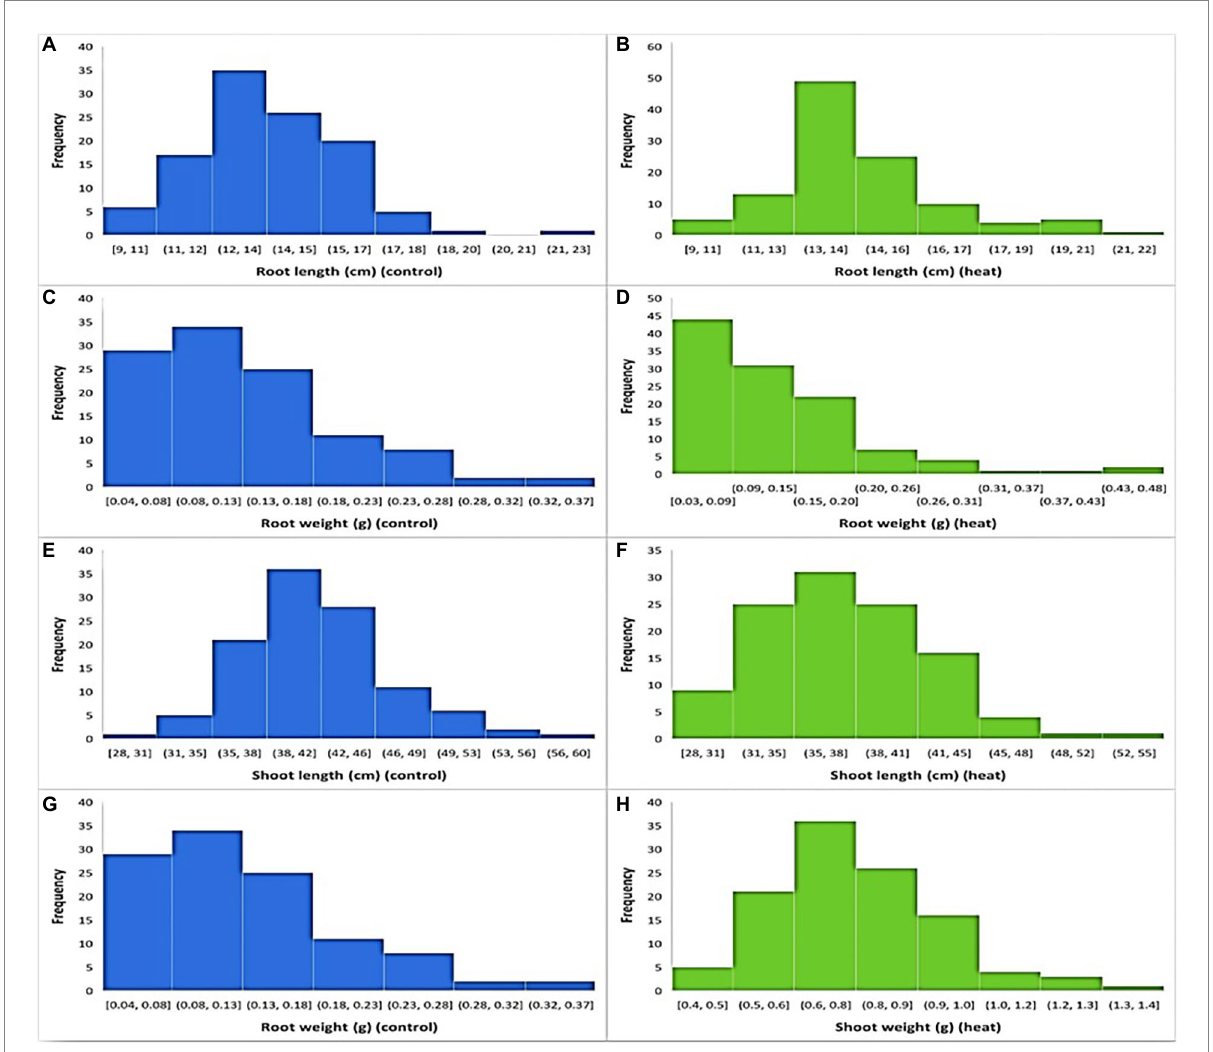
FIGURE 1 Frequency distribution of traits at optimal and heat stress condition. (A,B) shows root length at optimal and HS conditions, while (C,D) shows root weight, (E,F) shoot length, and (G,H) shows shoot weight at optimal and heat stress conditions, respectively.